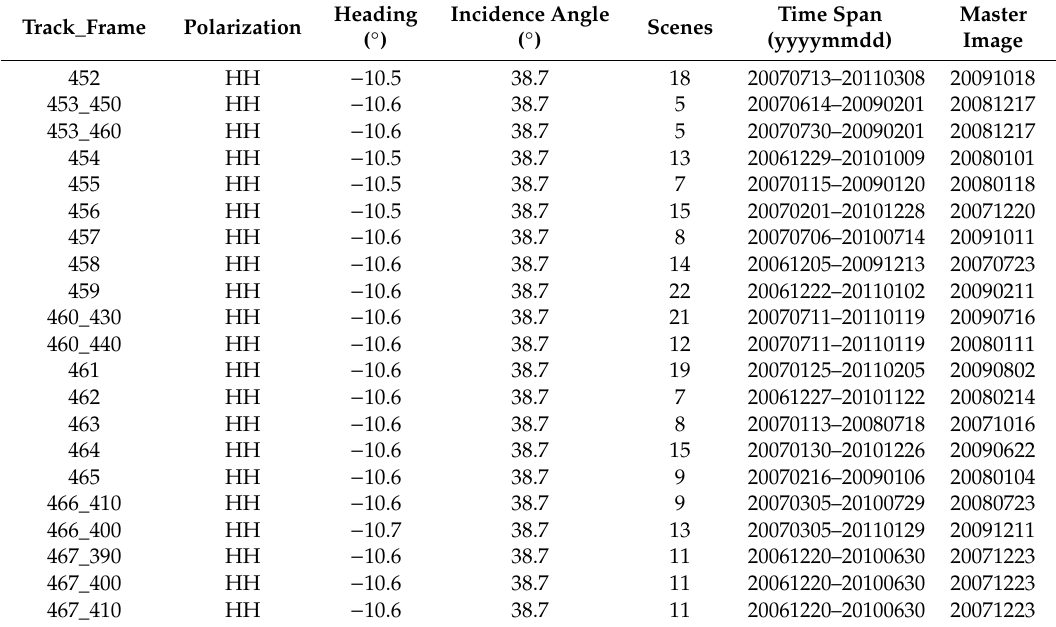
Table 1. SAR data and their imaging parameters.